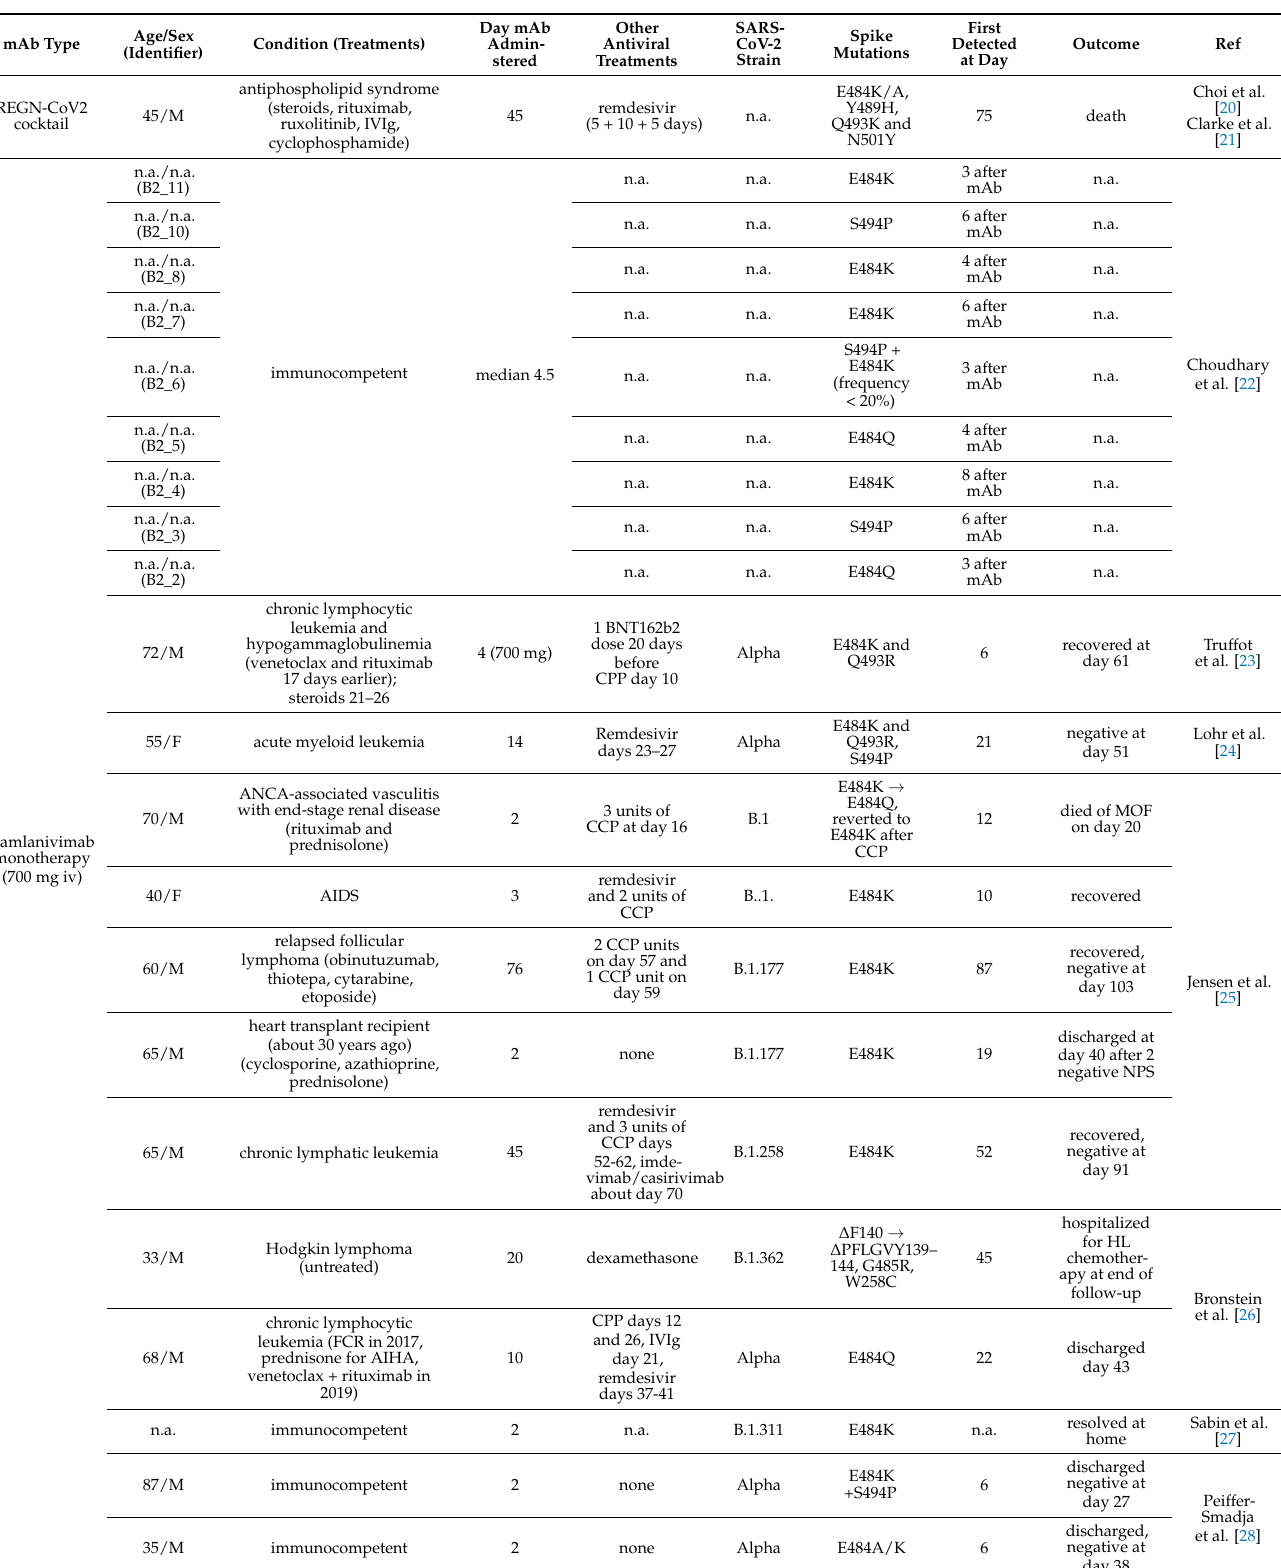
Table 2. Case reports of immune escape after anti-spike mAb